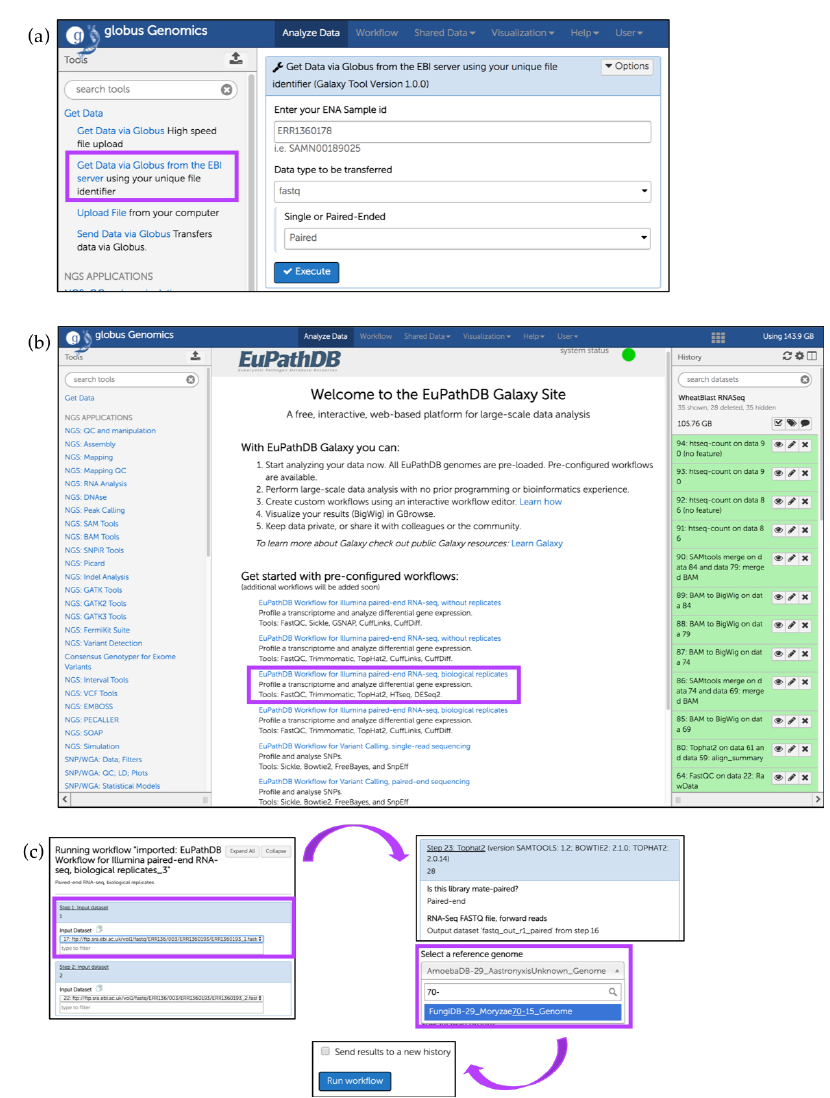
Figure 17. Running a preconfigured workflow for paired-end RNA-Seq data with biological replicates. ( a ) Upload files from EBI server (highlighted in purple); ( b ) Initiate a sample workflow by clicking on the corresponding workflow link (highlighted); ( c ) Choose preloaded paired datasets from the